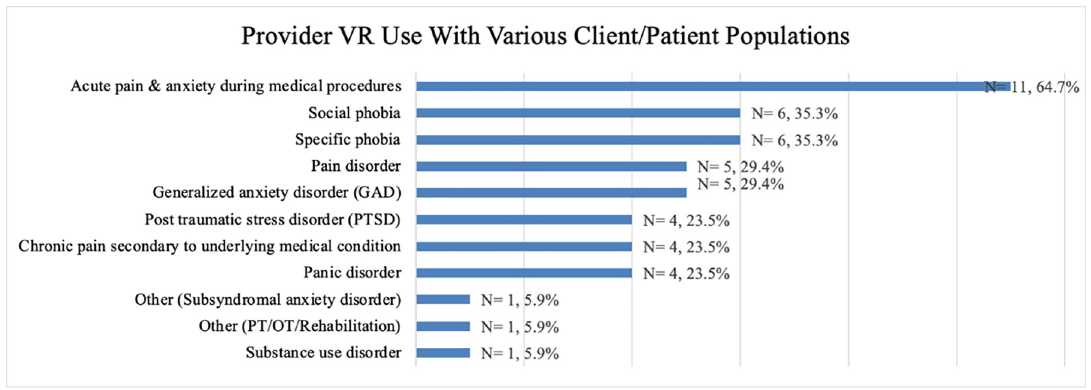
Fig 1. Provider VR use by percentage with various client/patient